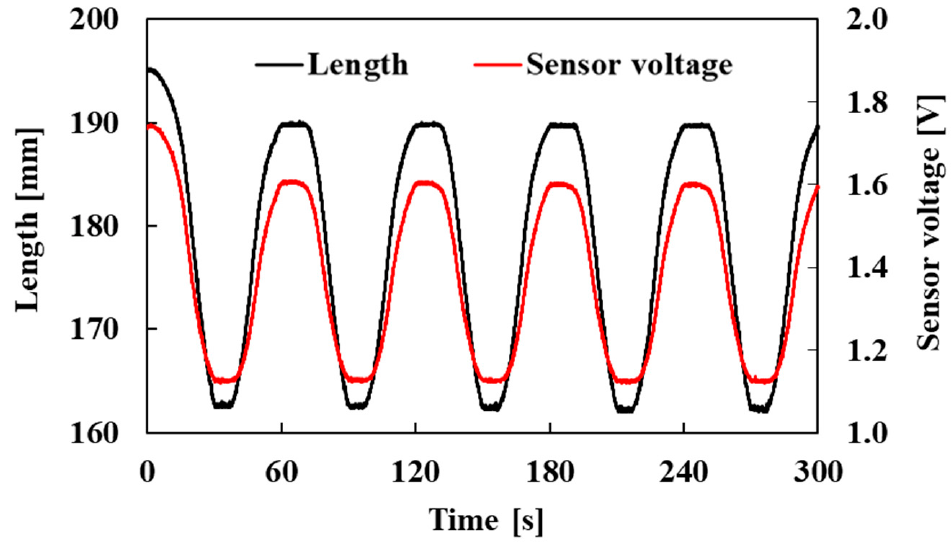
Figure 16. Length and sensor voltage variation with respect to time (pneumatic pressure: 0.0 MPa → 0.3 MPa → 0.0 MPa, five times).